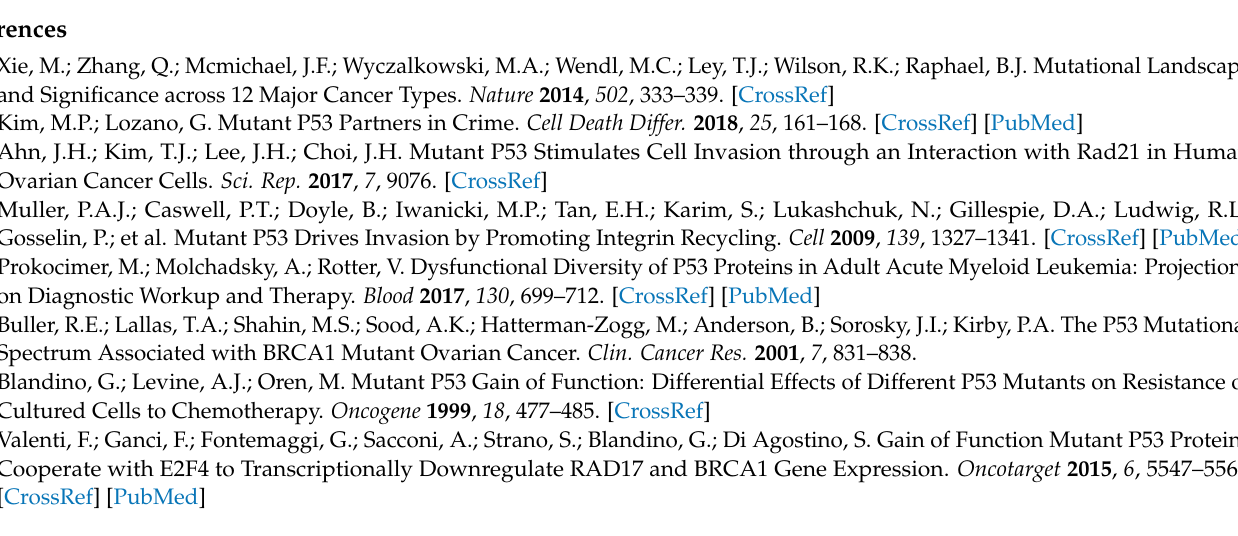
and size comparison, Figure S4: Cytotoxicity assay of the modified bPEIs and AuNPs, Figure S5: GEN3, Figure S7: Size and Zeta Potential measurements at different times, Figure S8: GEN2-AuNPs gel retardation assay and quantification, Figure S9: Cell viability studies in cancer cells after GEN2- AuNPs treatment, Figure S10: Fluorescence studies of oligonucleotide polyT(10)FAM release